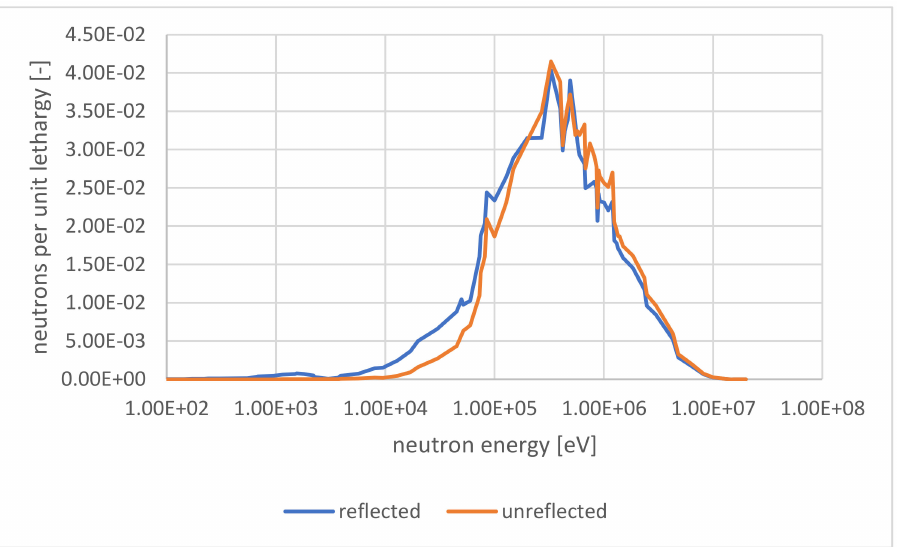
Figure 12. 2D study of the differences in the neutron spectrum caused by the control system for the 35% enriched reflected (lower core part) and unreflected (upper core part) core configuration using the heavy metal-rich salt